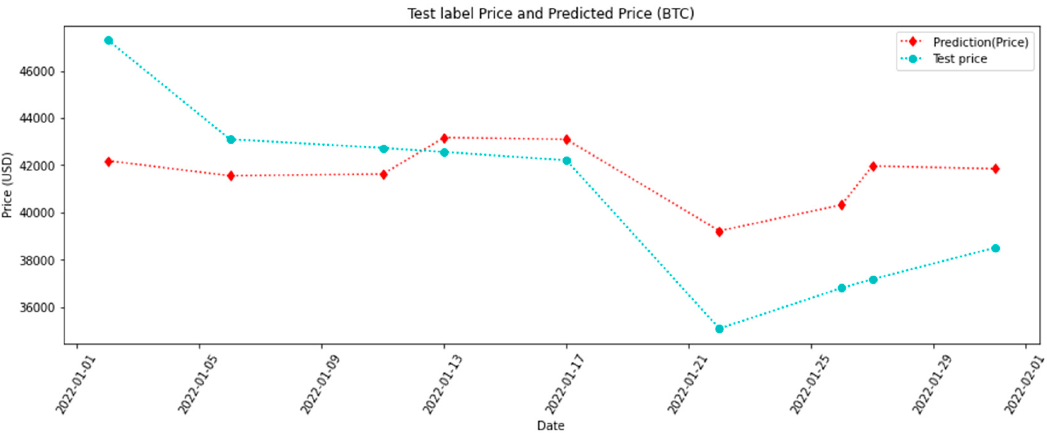
Figure 14. The plot of actual, test, and predicted trends in Ethereum.